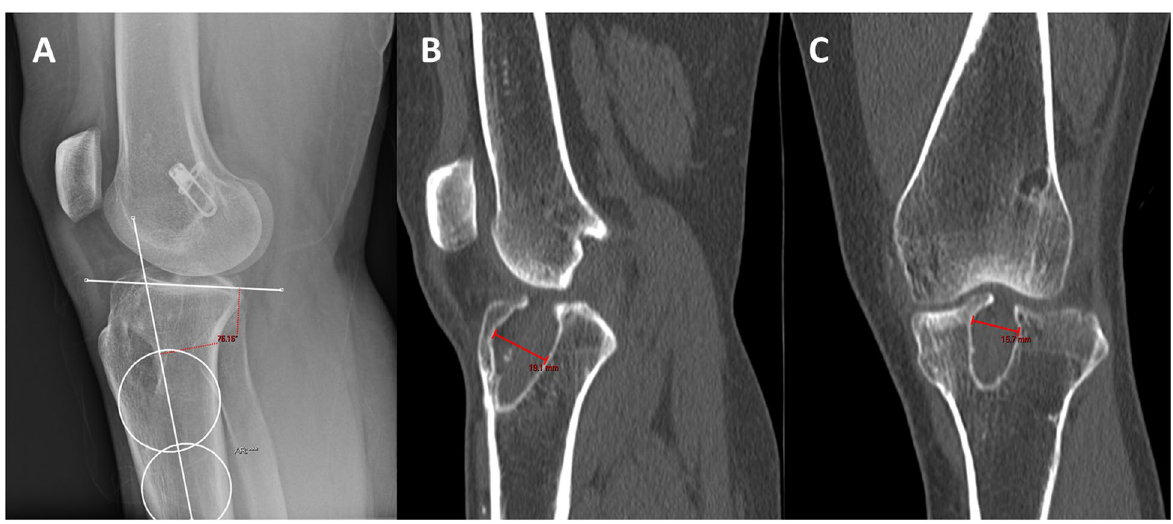
Fig. 2 Preoperative radiograph and CT scan slices showing posterior tibial slope of 14 degrees ( A ) with tunnel widening of 19 mm on the sagittal ( B ) and 16 mm on the coronal ( C